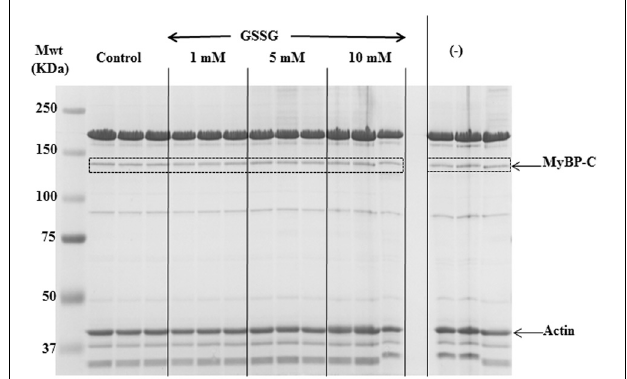
FIGURE 4 | SDS-PAGE gel for in-gel digestion. 8% SDS-PAGE gel stained with mass spectrometry compatible Imperial Protein Stain (Thermo); bands at ∼ 140kDa (dotted boxes) were cut out for mass spec